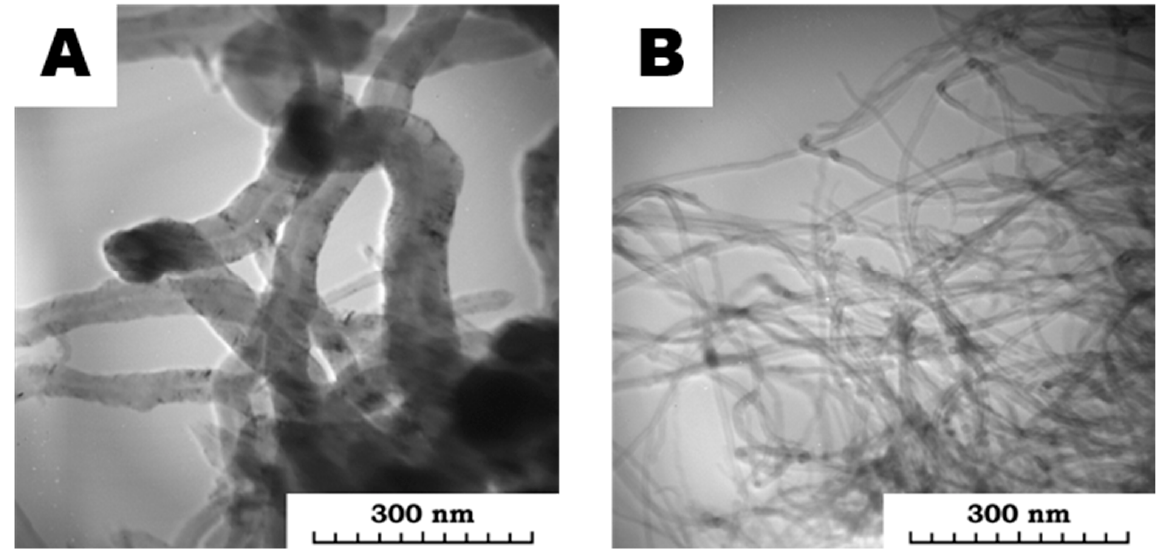
Figure 2. TEM of MWCNTs synthesized with ( A ) Ni/MgO and ( B ) Co-Mo/MgO catalysts.